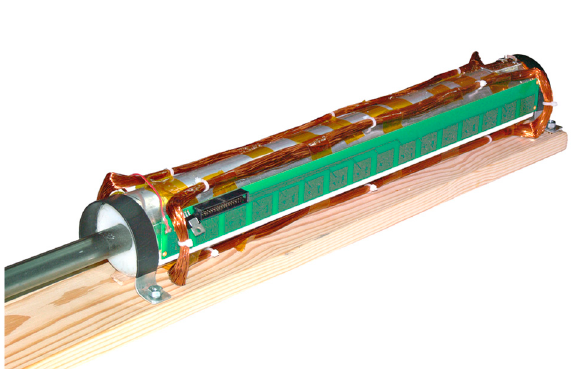
Figure 2. The actual position sensor is made of 16 integrated fluxgate sensors and is attached to the pneumatic actuator model which is 50 cm long and 6 cm in diameter.